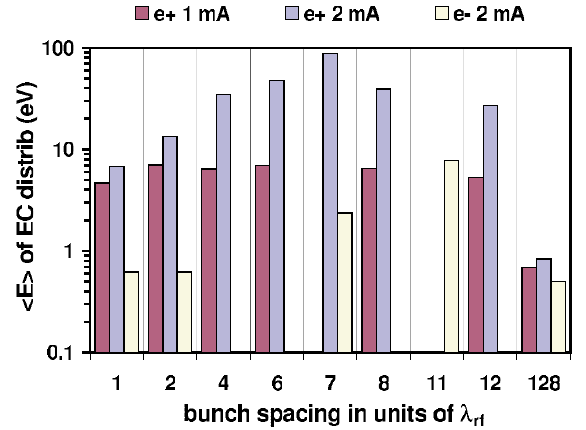
FIG. 14. (Color) Average wall collision energy calculated from measured electron-cloud energy distributions as a function of bunch spacing (ten bunches) for positron (1-mA and 2-mA bunch current) and electron (2-mA bunch current) beams. For these data, the highest average energy (100 eV) occurs for bunch spacing. In positron beams with 2 mA = bunch and 7- (cid:2) rf comparison, the highest average energy for electron beams bunch with 2-mA bunches is about 10 eV, occurring for 11- (cid:2) rf spacing. The lower average energy suggests that the cloud electrons are not getting as close to the beam with an electron beam compared with a positron beam. The average energy with 1-mA positron bunches is less than 10 eV. There is an additional surface conditioning of 100 Ah for the electron beam